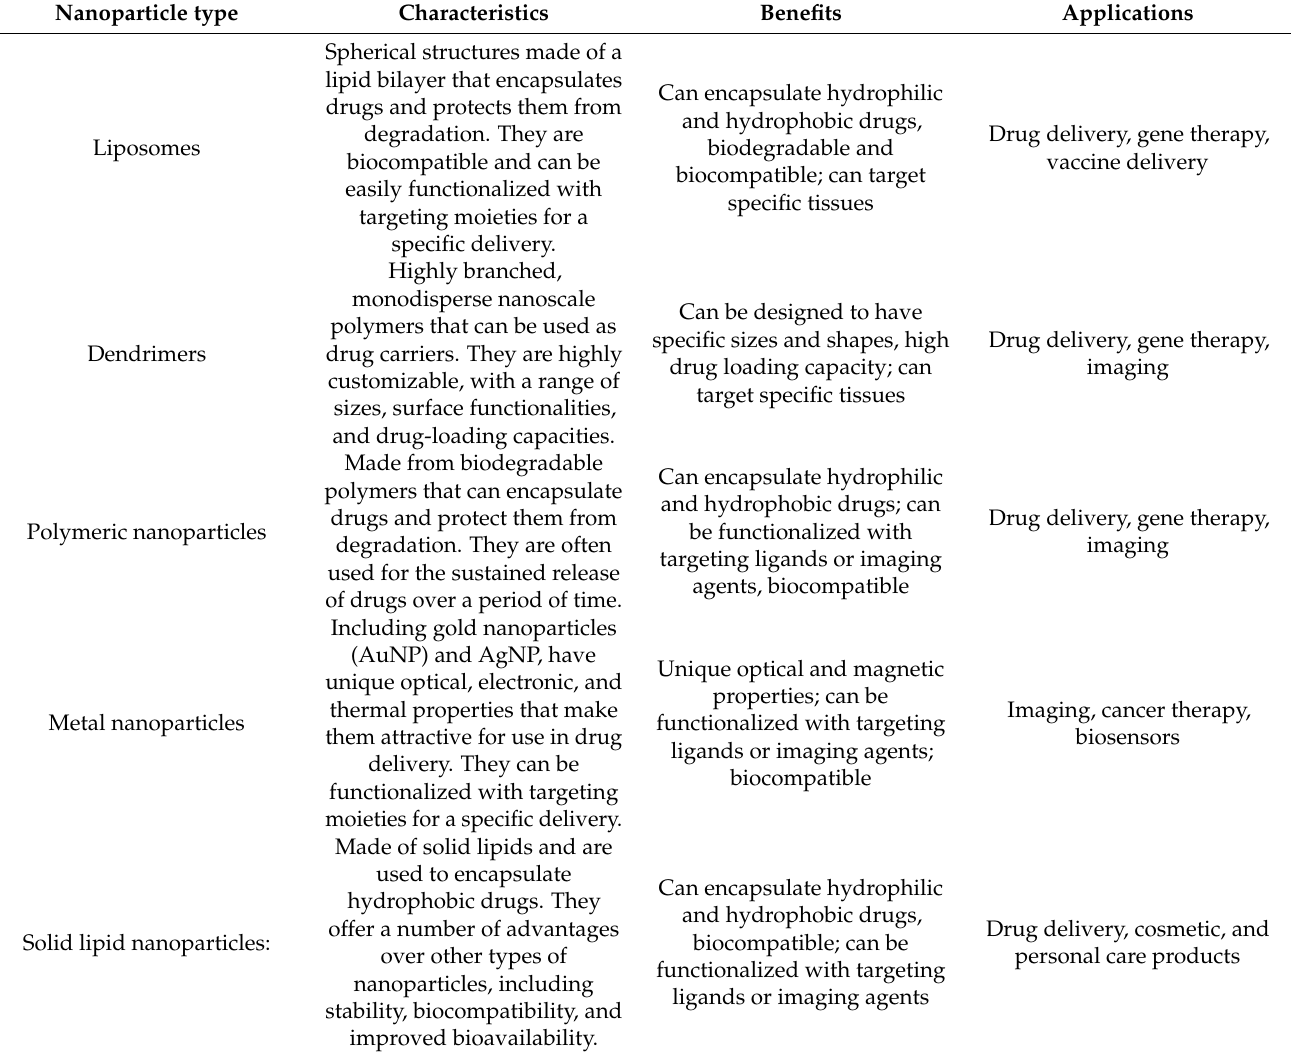
Table 2. Nanoparticle types, characteristics, benefits, and